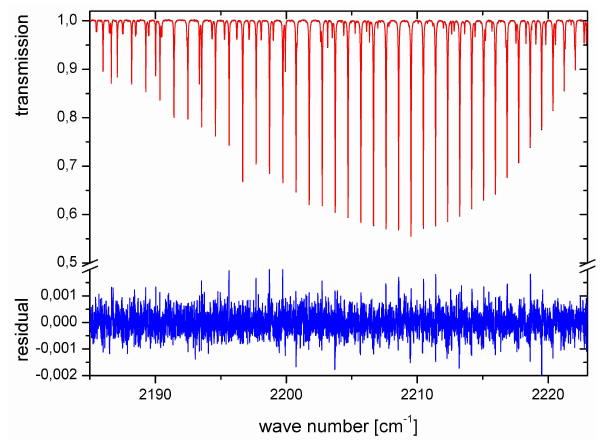
Fig. 8. The spectrum taken with cell C3 in July (black), super- imposed the synthetic spectrum fitted by LINEFIT is shown (red), blue: residual.